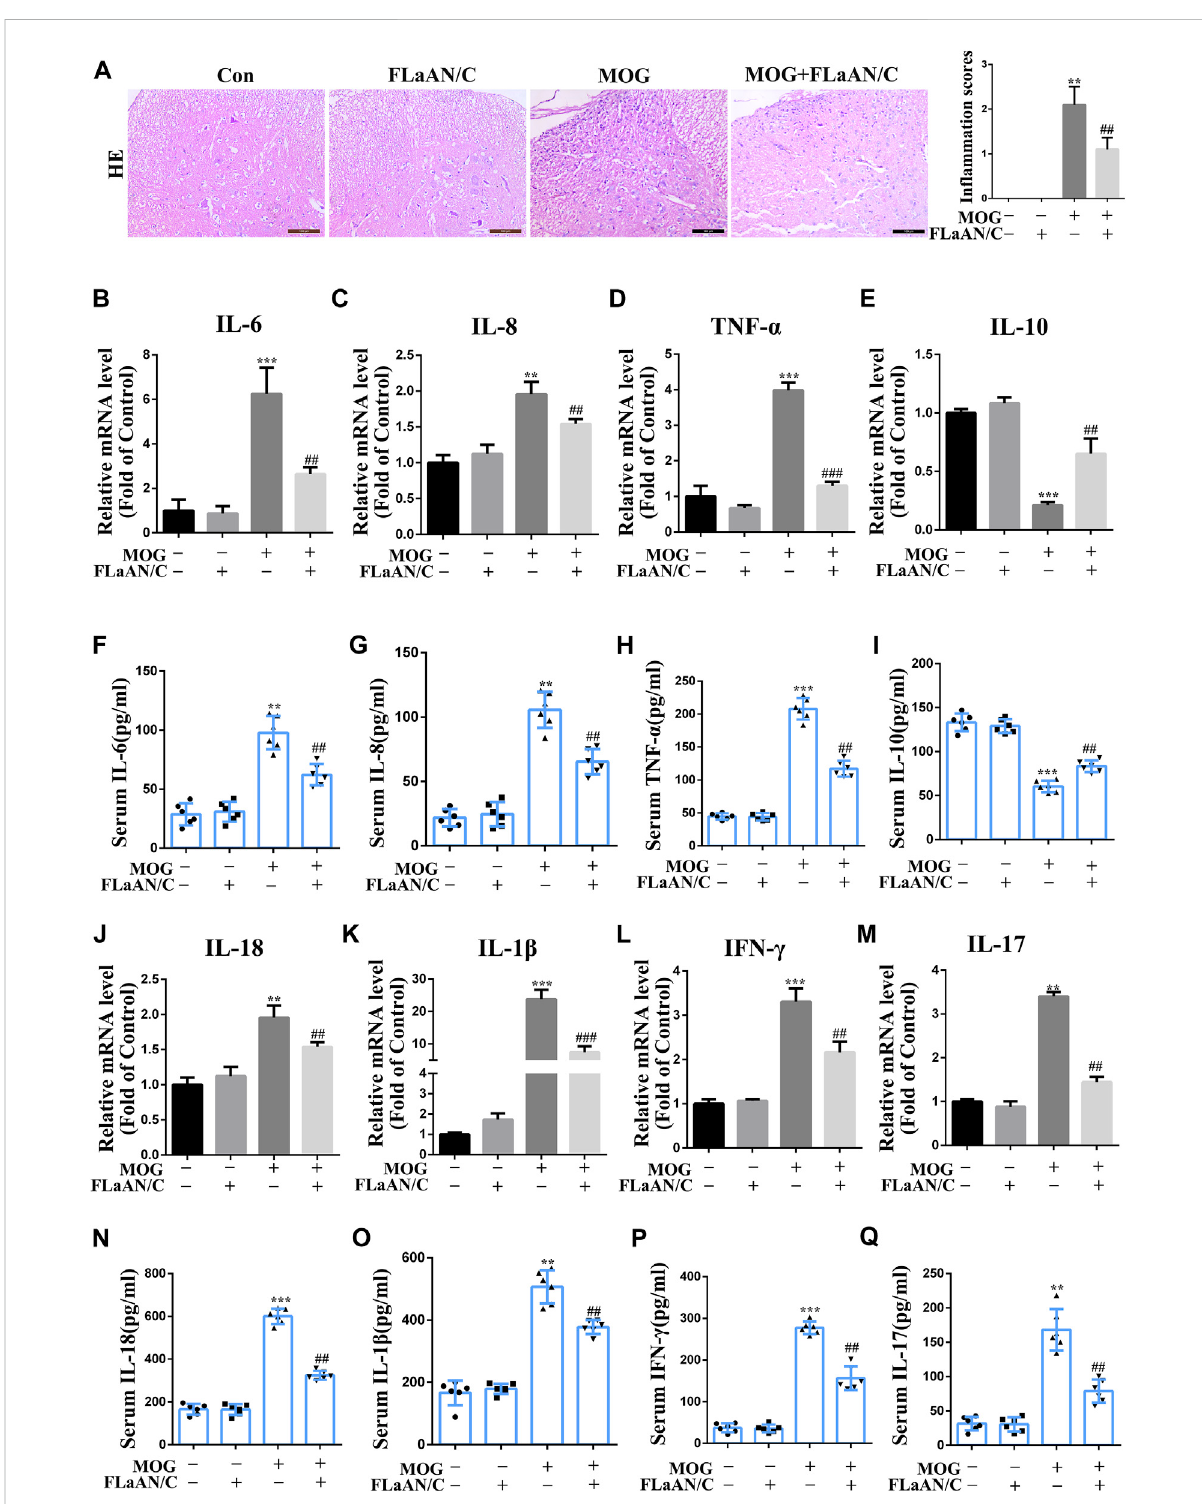
FIGURE 3 EffectsofFLaAN/Conin fl ammationinmicewithEAE. (A) H&Estainingwasperformedonparaf fi n-embeddedmousespinalcordsections(scale bars: 100 μ m). (B – E) The mRNA expressionof IL-6 (B) , IL-8 (C) , TNF- α (D) , and IL-10 (E) were quantitatedby qRT-PCR. (F – I) Serum levels of IL-6 (F) , IL-8 (G) , TNF- α (H) , IL-10 (I) were measured by ELISA. (J – M) The mRNA expression of IL-18 (J) , IL-1 β (K) , IFN- γ (L) , and IL-17 (M) were quantitated by qRT-PCR. (N – Q) Serumlevels of IL-18 (N) ,IL-1 β (O) , IFN- γ (P) , andIL-17 (Q) weremeasuredbyELISA. Data areshown as means± SD(n =6 per group). * p < 0.05, ** p < 0.01, *** p < 0.001; # p < 0.05, ## p < 0.01, ### p < 0.001. * vs. Control group; # vs. MOG